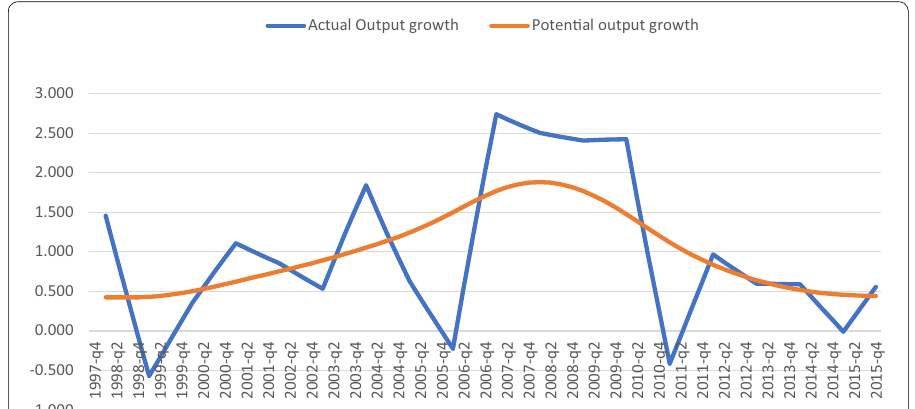
Fig. 2 Lebanese potential and actual GDP growth rate since QI‑199 to QIV‑2015. Source : Calculated by author using the Hodrick Prescott filter based on data for real GDP collected from World Bank